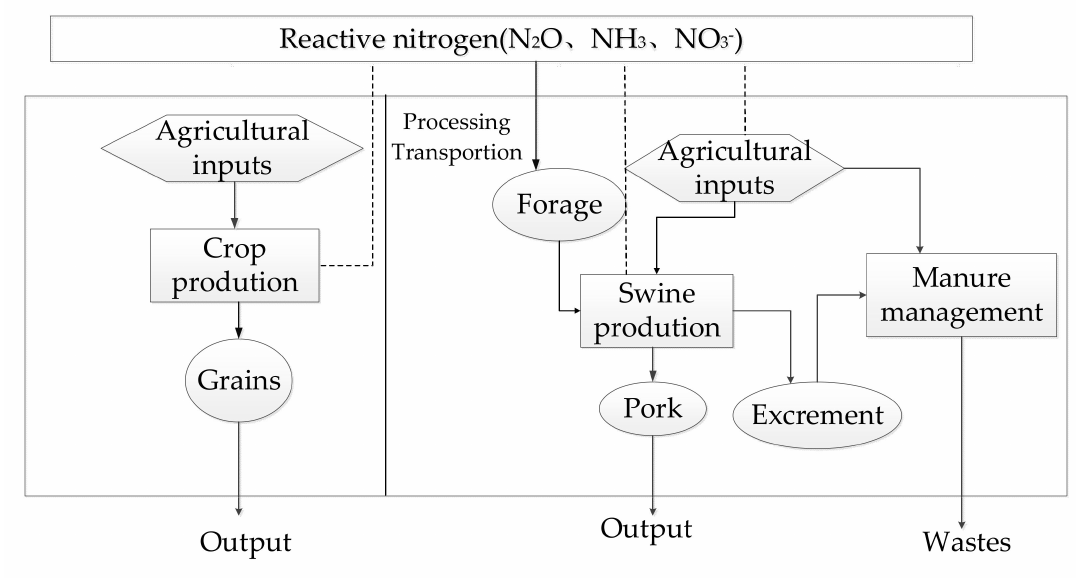
Figure 1. The system boundary of the separated system (SS). Notes: solid arrow denotes energy and material flow under agriculture practices, dotted arrow denotes reactive nitrogen emissions from